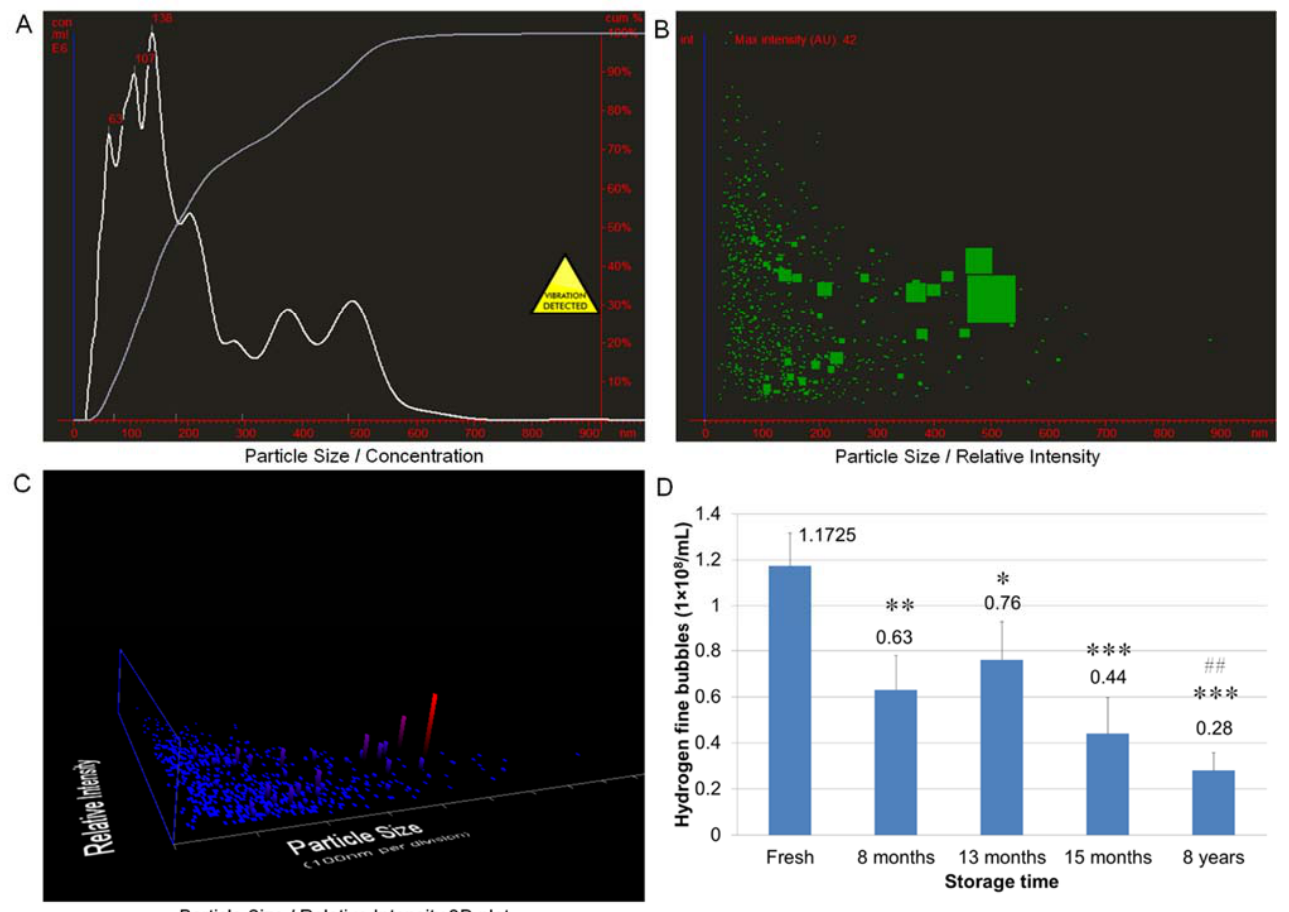
Figure 1. Concentration of hydrogen nano-bubbles in hydrogen nano-bubble water (HW). Nano-sized hydrogen bubbles in HW with different storage times were analyzed using Nanoparticle Tracking Analysis (NTA) software. Typical analysis results of particle size, distribution and number in HW are presented in ( A – C ). Numbers of hydrogen fine bubbles in HW samples were shown in ( D ). * p < 0.05, ** p < 0.01, *** p < 0.001 vs. fresh, ## p < 0.01 vs. 8 months. Each bar represents the mean ± SD of six independent experiments.